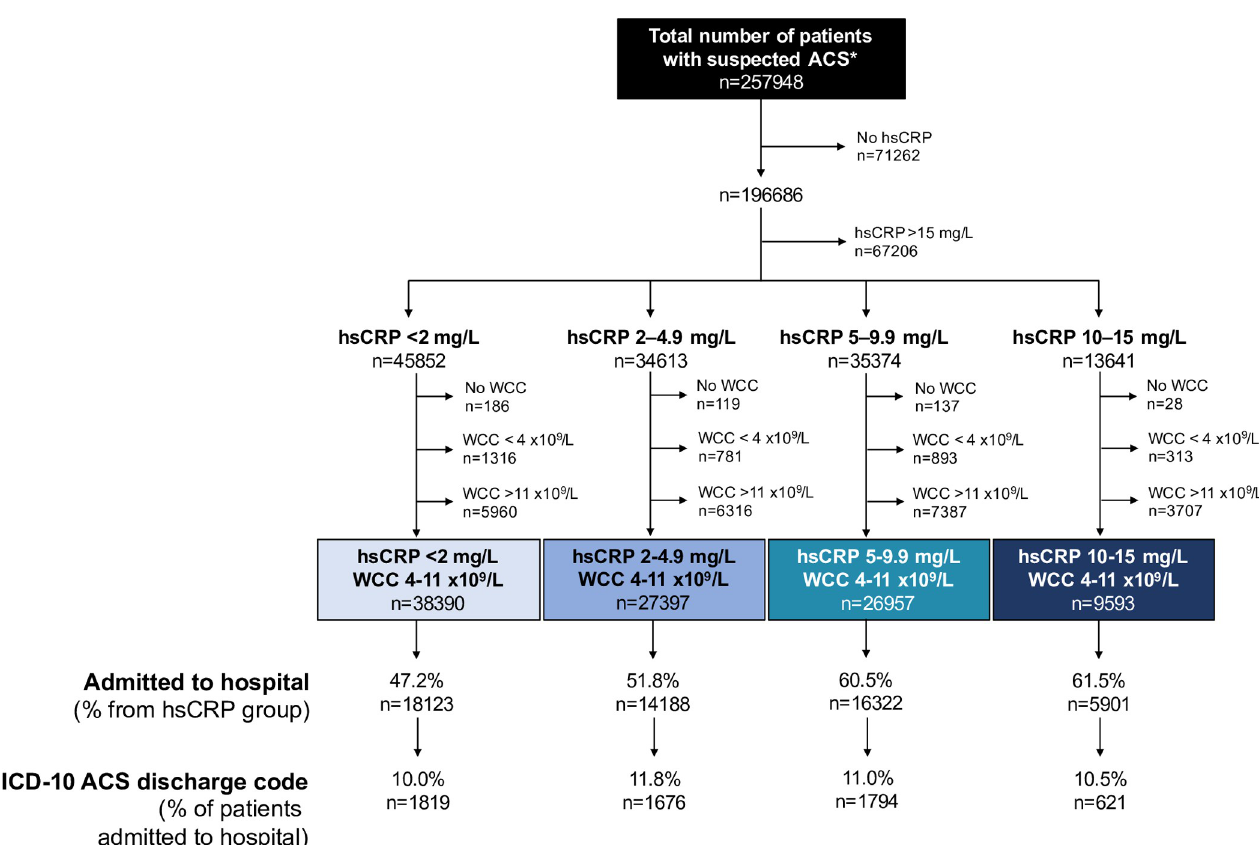
Fig 1. Flow of patients through the study. � Suspected ACS characterised by the request of a troponin. A AU : AbbreviationlistsofFigs 1 and 3 havebeenupdated : Pleaseverifythatallentriesarecorrect : CS, acute coronary syndrome; hsCRP, high-sensitivity C-reactive protein; ICD, International Classification of Diseases; WCC, white cell count.